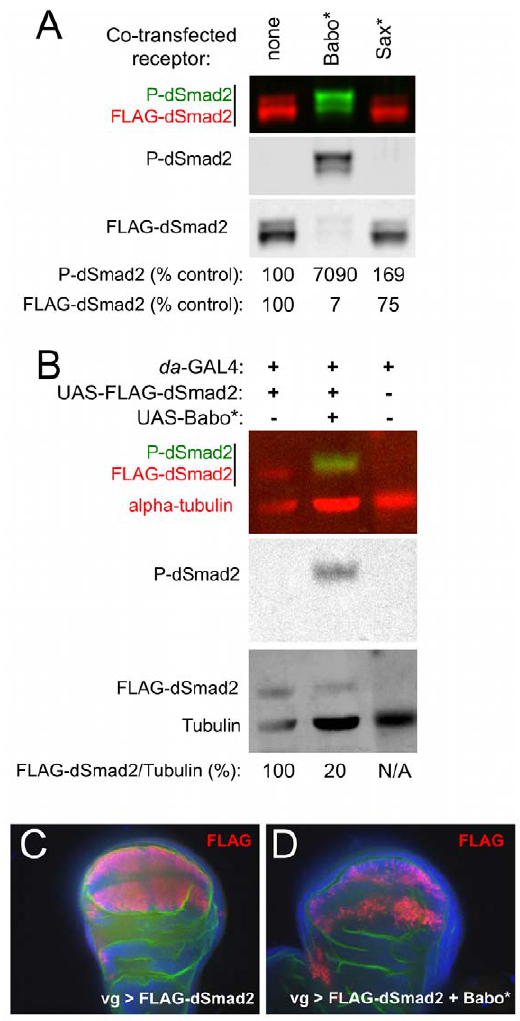
Figure 6. Hyperactive Baboon signaling leads to dSmad2 destabilization. The steady-state level of transfected dSmad2 in S2 cells was significantly reduced when Babo* was co-expressed (A). Quantified band intensities are displayed as a percentage of the control for each channel. Note that the P-dSmad2 level was greatly increased but the total dSmad2 level was reduced in the presence of Babo*, causing a greater than 1000-fold increase in the ratio of P-dSmad2 to total Flag-dSmad2. This effect was specific to Babo*, as inclusion of activated Saxophone (Sax*) neither stimulated P-dSmad2 nor signifi- cantly decreased the FLAG-dSmad2 signal (A, right lane). FLAG-dSmad2 was expressed in embryos using the da -GAL4 driver, either alone or with Babo* (B). Total exogenous dSmad2 and P-dSmad2 was detected by Western blot and the amount of FLAG-dSmad2 was normalized to endogenous alpha-tubulin. (C, D) vg -GAL4 was used to express Flag- dSmad2 alone (C) or with Babo* (D) in the wing disc. FLAG antibody IHC was used to gauge dSmad2 levels (red), and DAPI (blue) and aPKC IHC (green) are shown as counter-stains. Each image is a single confocal plane through the wing blade, and represents at least three discs stained per genotype.